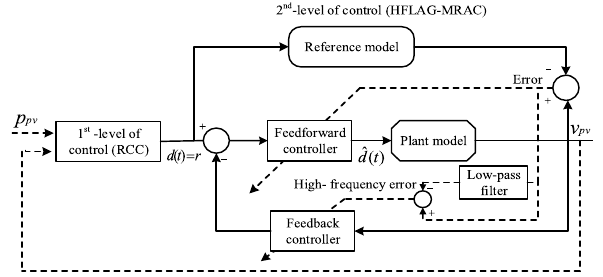
Figure 4. Representation of the proposed 2-level MPPT MRAC control